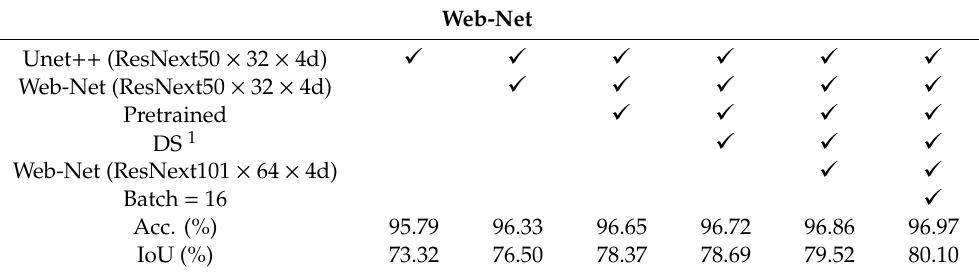
Table 4. Various Design Results.